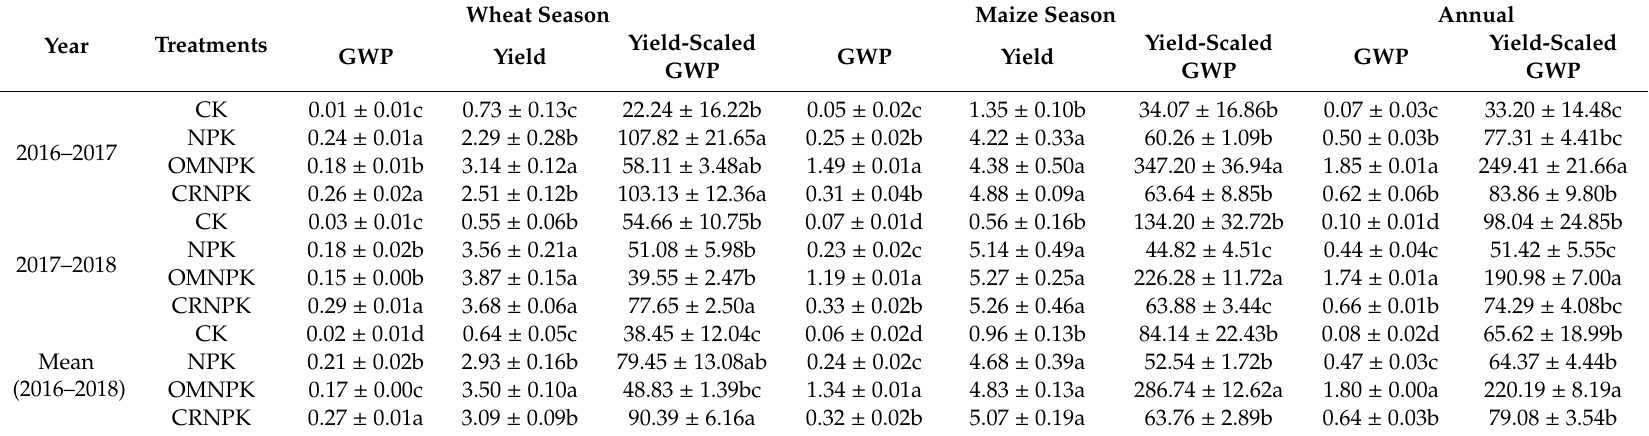
Mean ± SE: Means in columns followed by di ff erent lower case letter are significantly di ff erent (least significant di ff erence (LSD), p < 0.05) and means followed by the same lower case letter are not significantly di ff erent (LSD, p > 0.05). No amendment as control (CK), mineral fertilizers (NPK), pig slurry combined with mineral fertilizers (OMNPK), and crop residues combined with mineral fertilizers